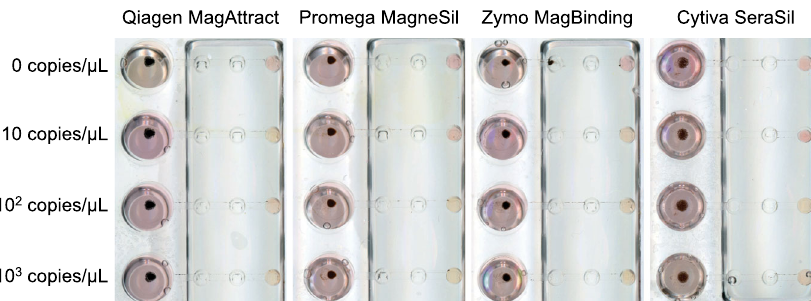
Fig. 3 Integrated extraction and LAMP detection of γ -irradiated inactivated SARS-CoV-2 particles with OIL-TAS. Performance of the OIL-TAS assay with magnetic silica beads from various vendors paired with an open-source lysis buffer (recipe in the “ Methods ” section) for integrated RNA extraction and LAMP detection of SARS-CoV-2. Magnetic beads are magnetically moved back into the sample (large) well following LAMP ampli fi cation to enable clearer visualization of color change.